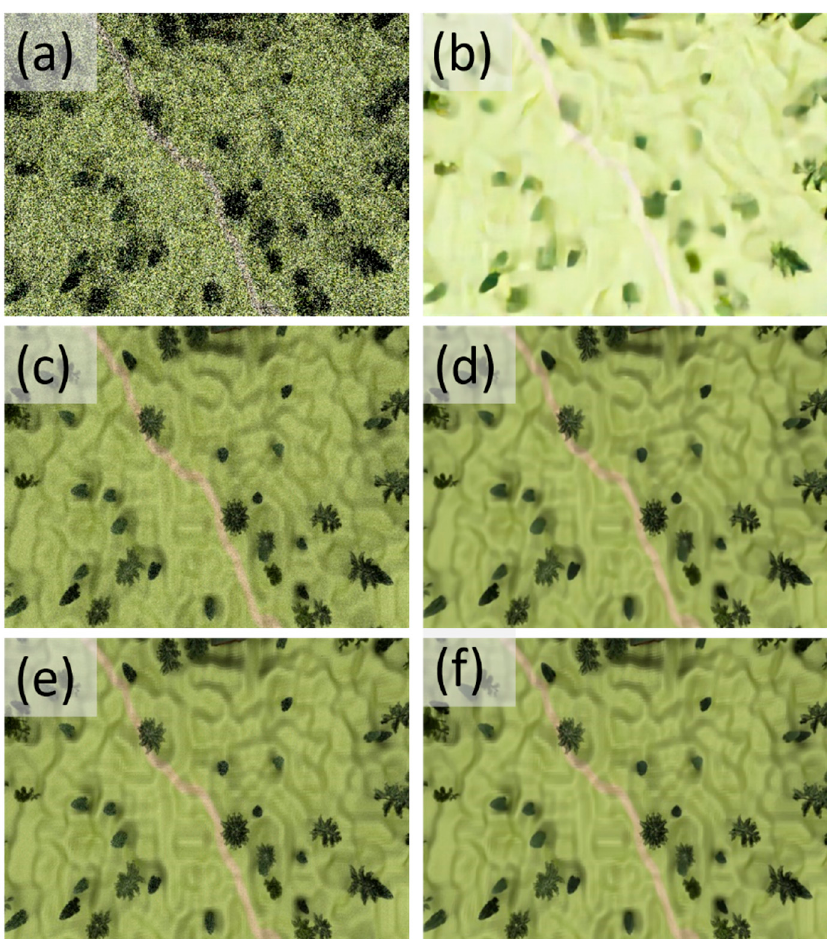
Figure 7. Sample Raw Images on the left ( a , c , e ) and Denoised Images on the right ( b , d , f ). Images ( a , b ) 1 rays per pixel, ( c , d ) 100 rays per pixel, and ( e , f ) 10,000 rays per pixel.